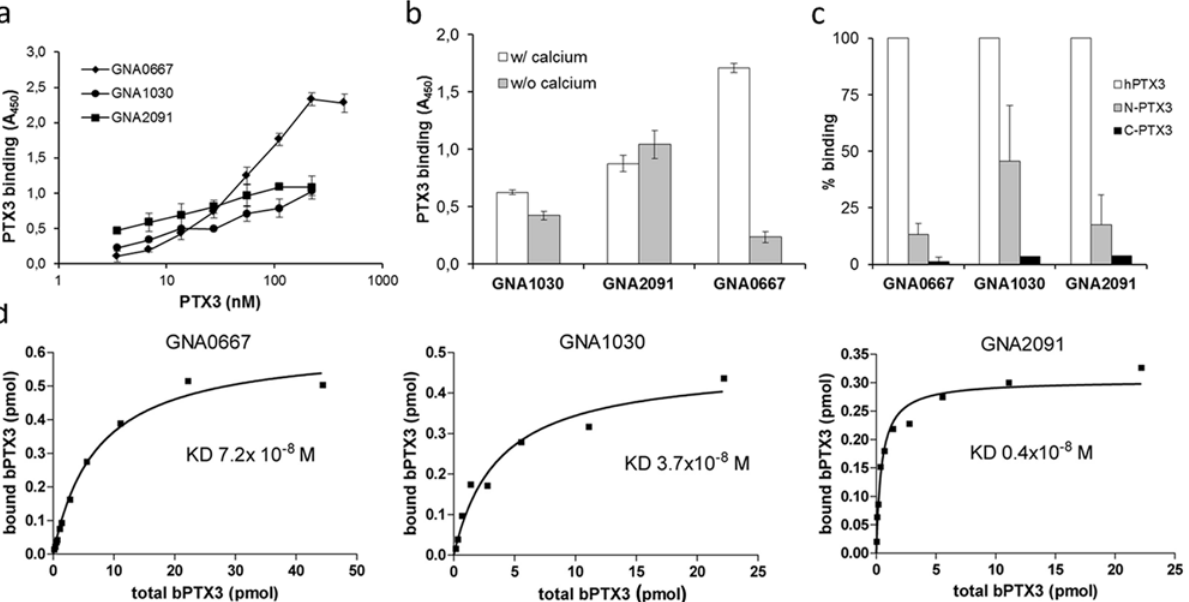
Fig 4. Characterization of PTX3 interaction with recombinant proteins from Neisseria meningitidis . a) Microtiter plate assay of the binding of different doses of bPTX3 to recombinant GNA0667, GNA1030 and GNA2091 (each used at 1 μ g/well). b) Binding was performed in the presence or not of calcium. Results are from four independent experiments (mean ± SD of triplicate wells). c) Microtiter plate assay of the binding of recombinant N-terminal or C-terminal PTX3 domains (22 pmoles) to GNA0667, GNA1030 and GNA2091. Data are expressed as percentage of binding compared to recombinant full length PTX3 (mean ± SD from three independent experiments). d) Affinity of the interaction between GNA0667, GNA1030 and GNA2091, and various amount of bPTX3: specific binding was measured in accordance with a standard curve of bPTX3 with non-linear fitting analysis. Data are representative of three experiments.